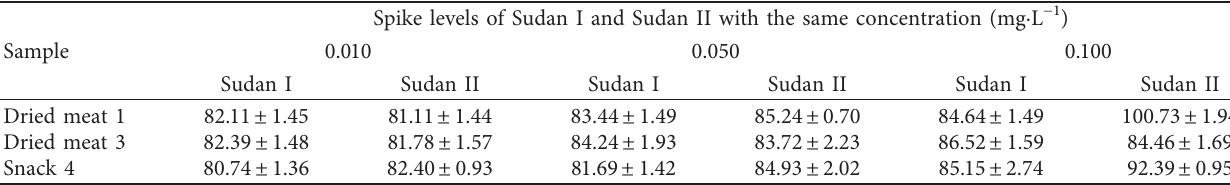
Table 4: Recoveries from food samples.